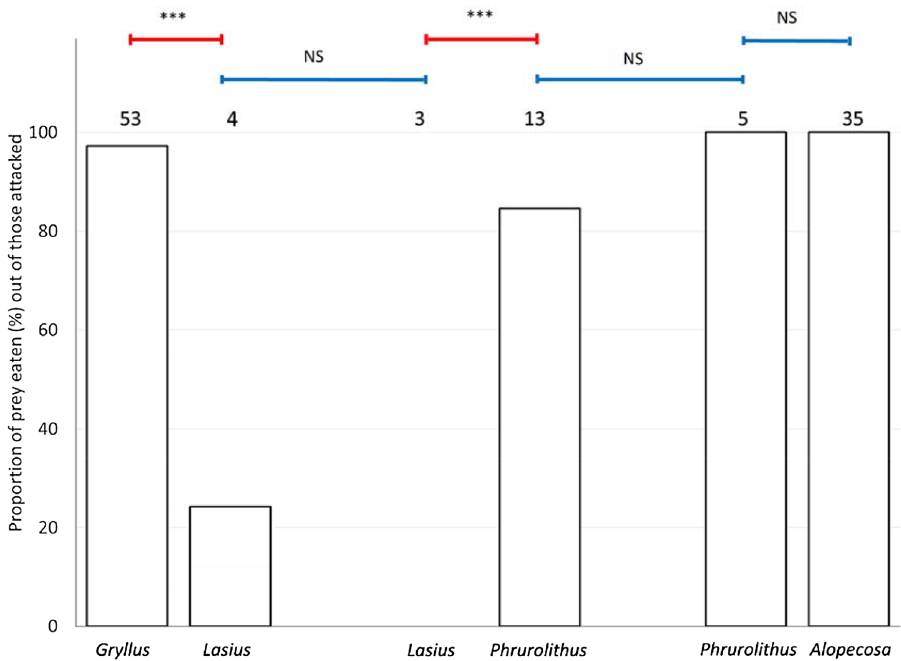
Figure 4. The proportion of particular prey being eaten after the attack. Gryllus —Mediterranean cricket ( Gryllus bimaculatus ), Lasius —black garden ant ( Lasius niger ), Phrurolithus —myrmecomorph spider ( Phrurolithus festivus ), Alopecosa —non-myrmecomorph wolf spider of genus Alopecosa . The numbers above each column refer to the number of particular prey being attacked and thus included in this analysis. Red lines with an asterisk above the columns indicate significant difference, blue lines indicate non-significant difference (NS) 42